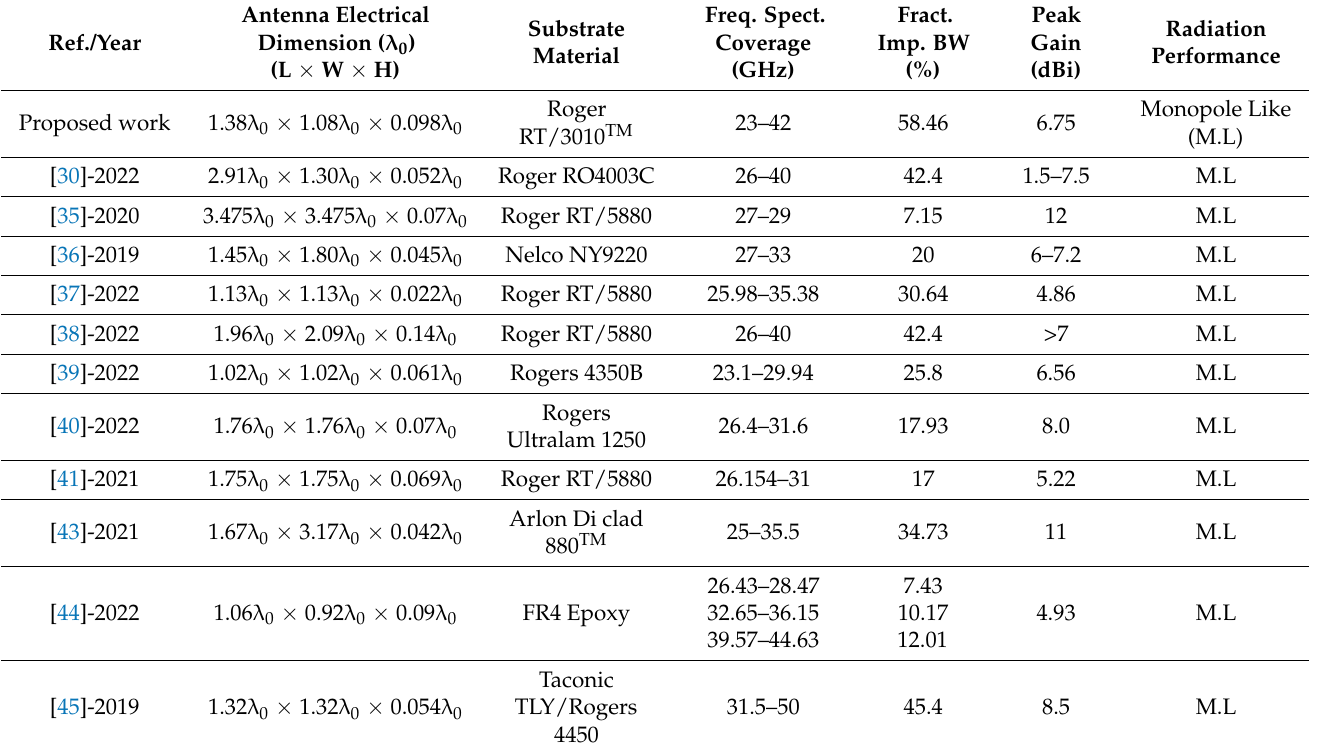
Table 2. Performance comparison analysis of the proposed antenna and recently reported